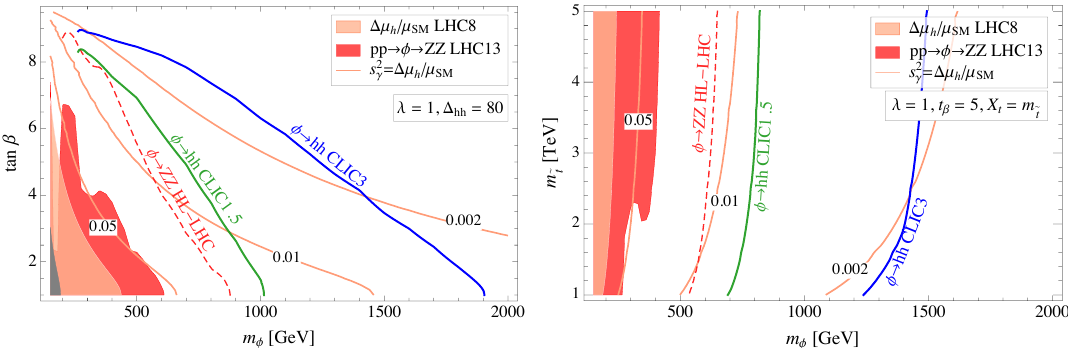
Figure 8. Constraints at 95% C.L. The shaded regions are the present constraints from LHC direct searches for (cid:30) ! ZZ (red) and Higgs couplings measurements (pink). The reach at CLIC Stage 2 and Stage 3 (blue) is compared with the projections for LHC with a luminosity of 3 ab (cid:0) 1 (dashed red). We have (cid:12)xed BR (cid:30) ! hh = BR (cid:30) ! ZZ = 25%. Left: plane ( m (cid:30) ; tan (cid:12) ). Right: